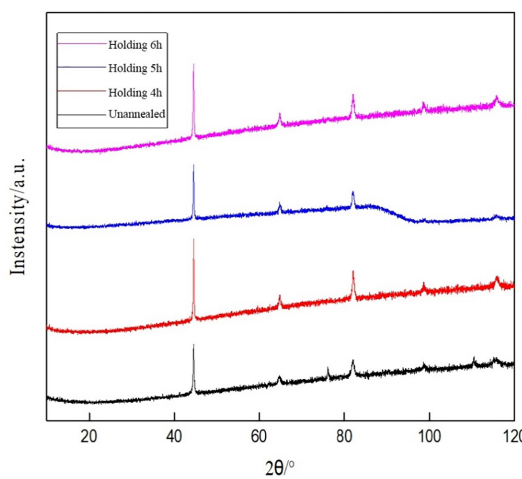
Figure 7. XRD curve of SMAW welded joint under different annealing